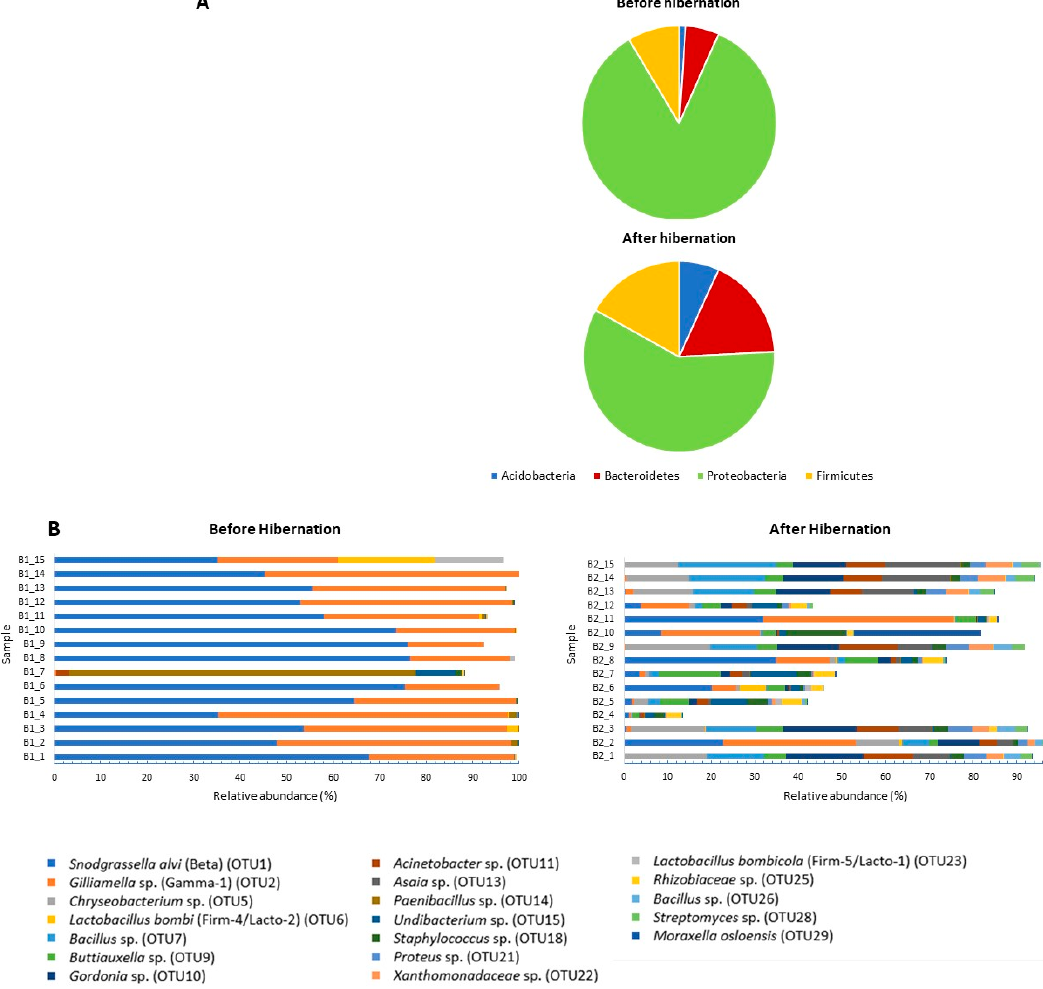
Figure 3. ( A ) Relative abundance (%) of the bacterial phyla found in the midgut and/or ileum of indoor-reared bumblebee queens ( Bombus terrestris ) before ( n = 15) and after hibernation ( n = 15). ( B ) Gut bacterial community composition at the level of operational taxonomic units (OTUs). Only the most abundant OTUs (i.e., with a mean sequence relative abundance ( n = 30) >1%) are represented in the figure. OTUs were identified by a BLAST (basic local alignment search tool) search against type materials in GenBank and identified up to species level if only one top hit was obtained. Note that the Paenibacillus OTU (OTU14) is not related to Paenibacillus larvae , which is a species lethal to honey bee and bumblebee larvae. The highest sequence similarity was found with type strains of Paenibacillus amylolyticus , P. pabuli , P. taichungensis , P. tundra , P. tylopili , P. xylanexedens , and P. xylanilyticus (for all 100% sequence identity on a total of 250